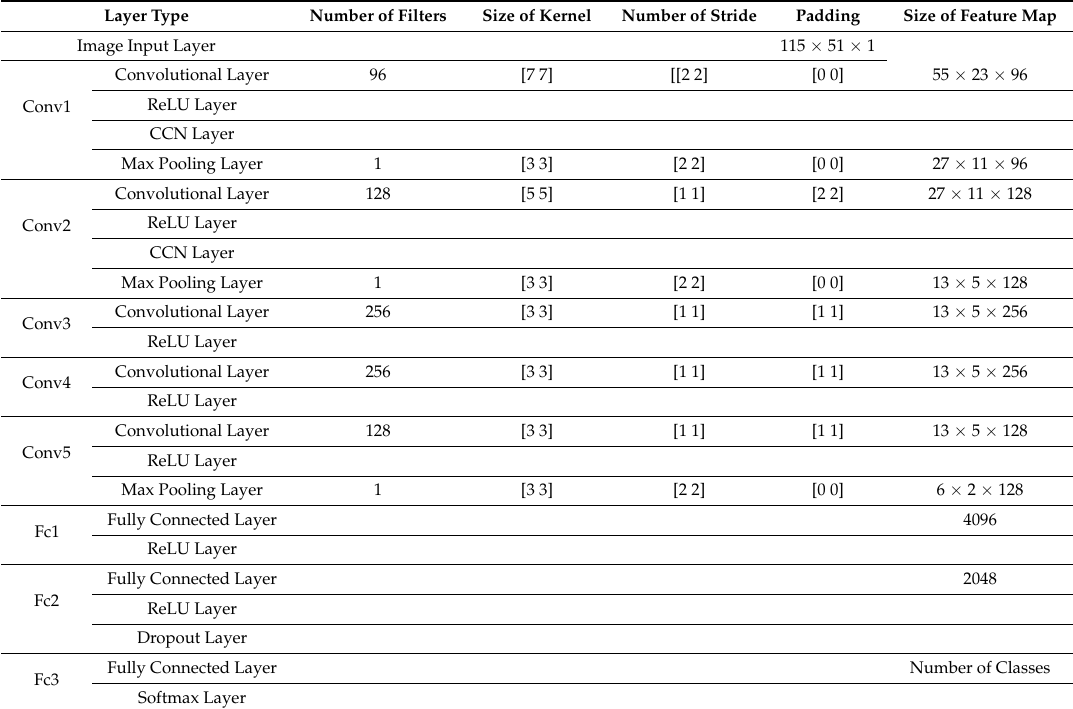
Table 2. Structure of the CNN using in our banknote recognition